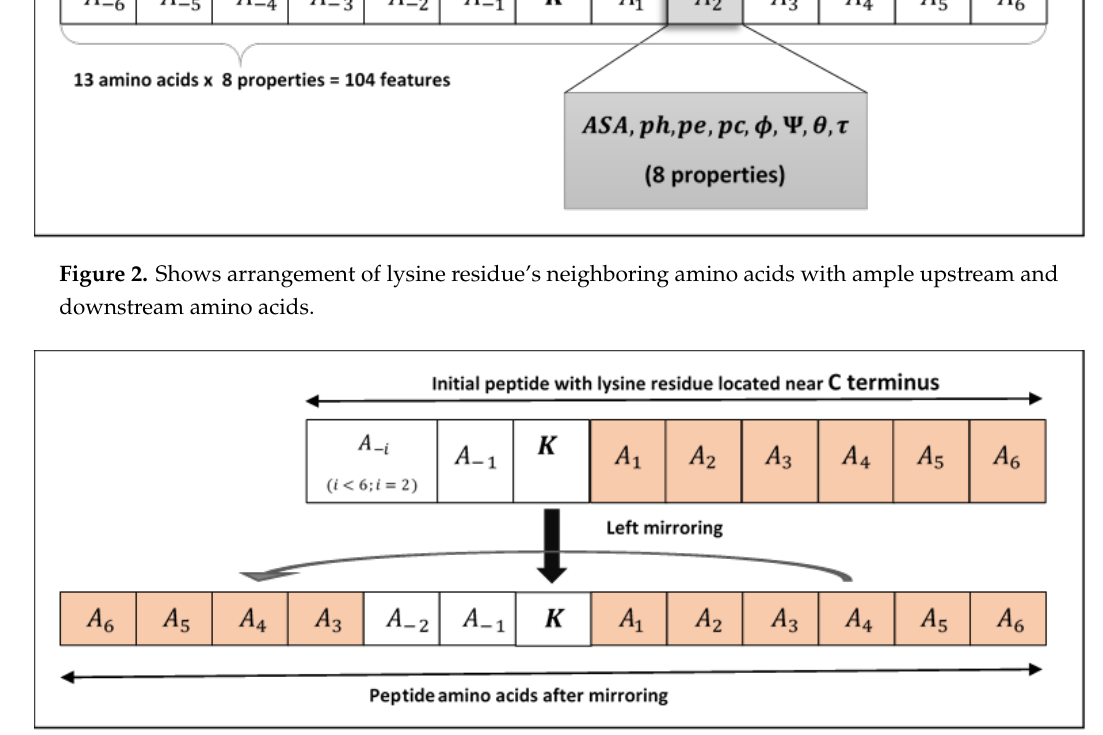
Figure 3. Shows lysine with insufficient amino acids. Left mirroring is illustrated to get sufficient upstream amino acids.